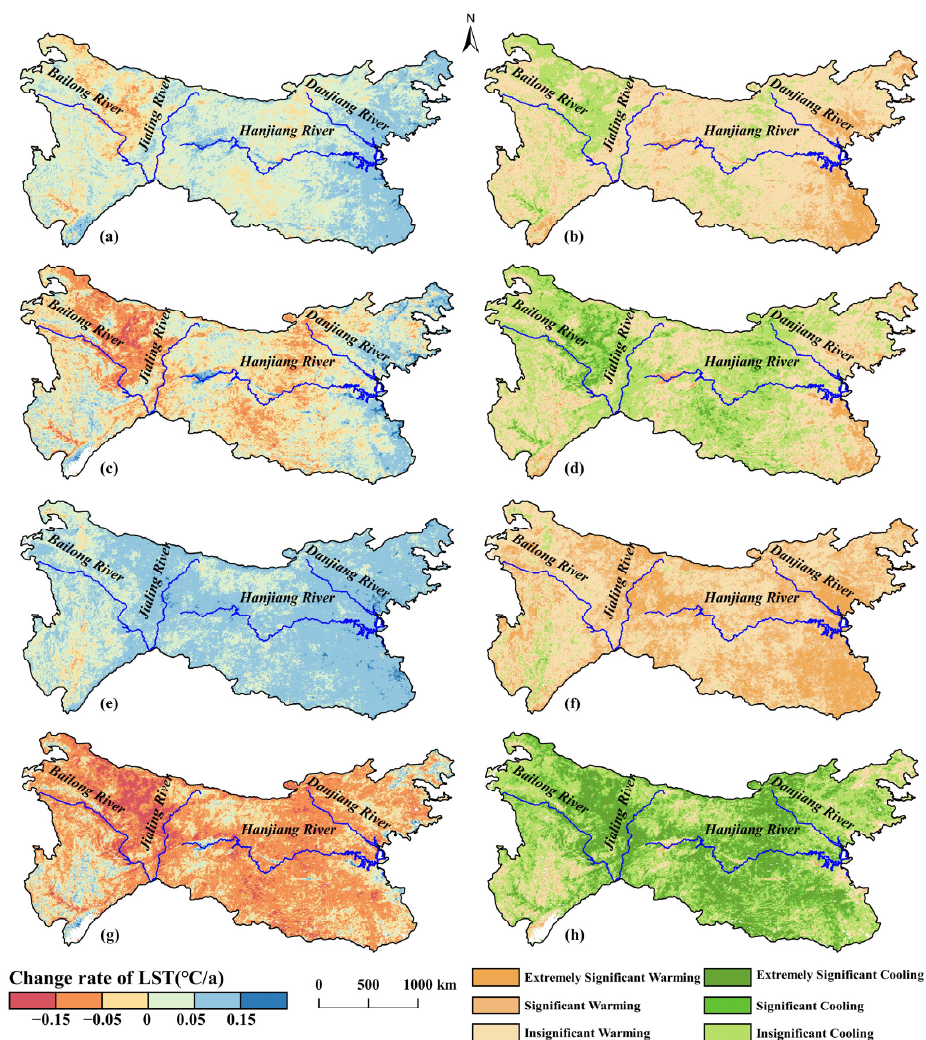
Figure 4. The interseasonal variability rates (slope) and trend significance of LST in the Qinling-Daba Mountains from 2000 to 2020: ( a , b ) spatial distributions of slope and trend significance for the average annual LST; ( c , d ) spatial distributions of slope and trend significance for the daytime LST; ( e , f ) spatial distributions of the slope and trend significance for the nighttime LST; and ( g , h ) spatial distributions of the slope and trend significance for DIF.